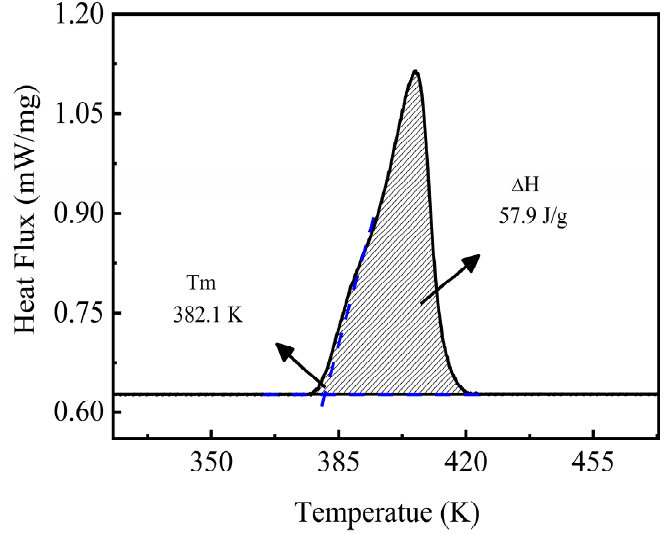
Figure 6. Melting point and fusion enthalpy of the NaNO 3 -KNO 3 -Ca(NO 3 ) 2 (16:48:36 wt%) ternary salt.